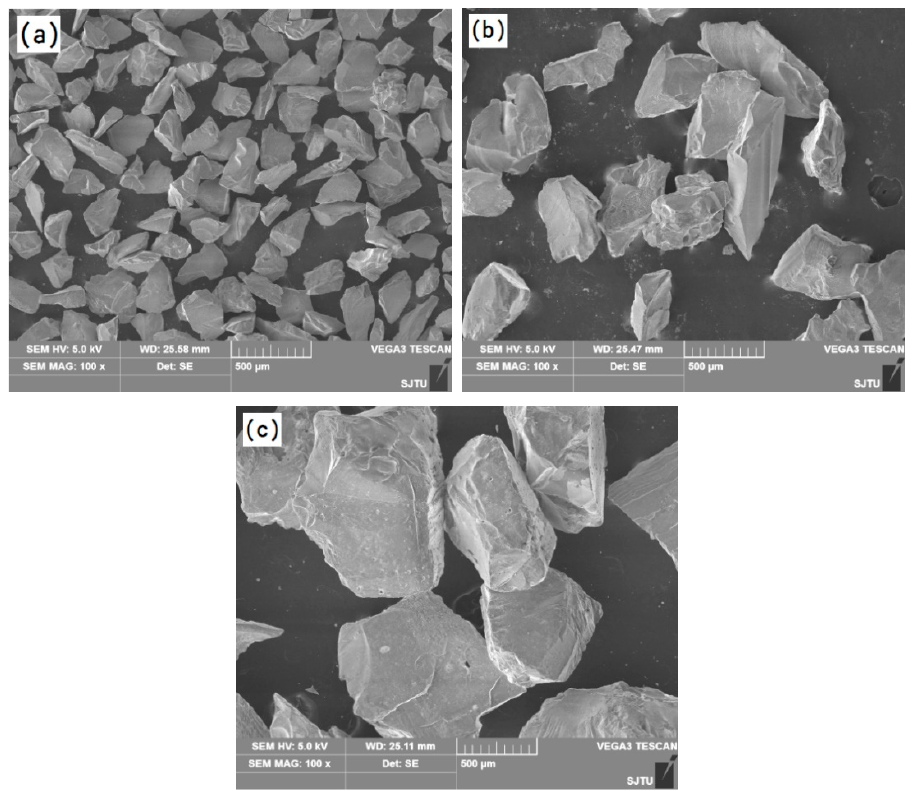
Figure 5. SEM micrographs of fused alumina sands: ( a ) 80-mesh; ( b ) 46-mesh and ( c ) 24-mesh.